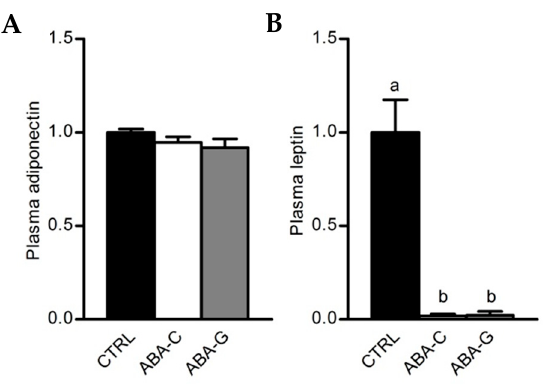
Figure 6. Plasmatic levels of adiponectin and leptin. Adiponectin ( A ) and leptin ( B ) plasmatic levels were measured for Gln supplementation test by multiplex assay. Column bar graphs show control mice (CTRL; black bars, n = 8), non-supplemented activity-based anorexia mice (ABA-C; open bars, n = 8) and supplemented activity-based anorexia mice (ABA-G; grey bars, n = 7). Values without a common letter significantly differ ( p < 0.05).